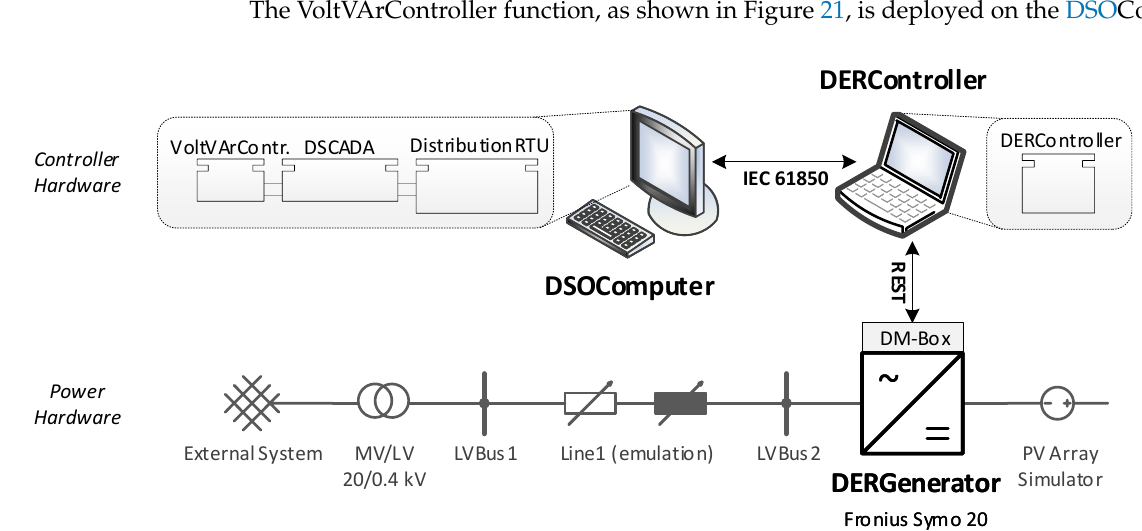
Figure 22. Laboratory setup for the validation use case (adopted from Reference